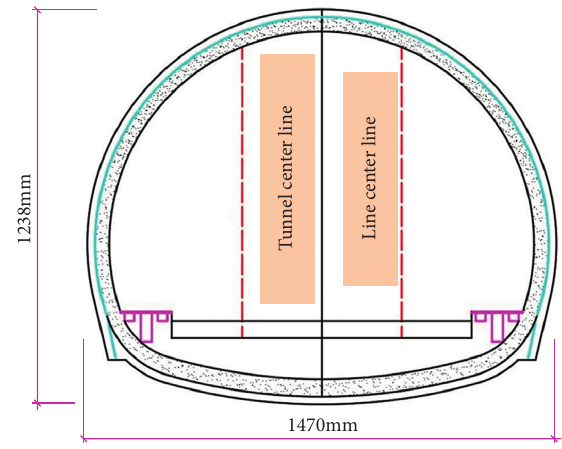
Figure 1: Tunnel section